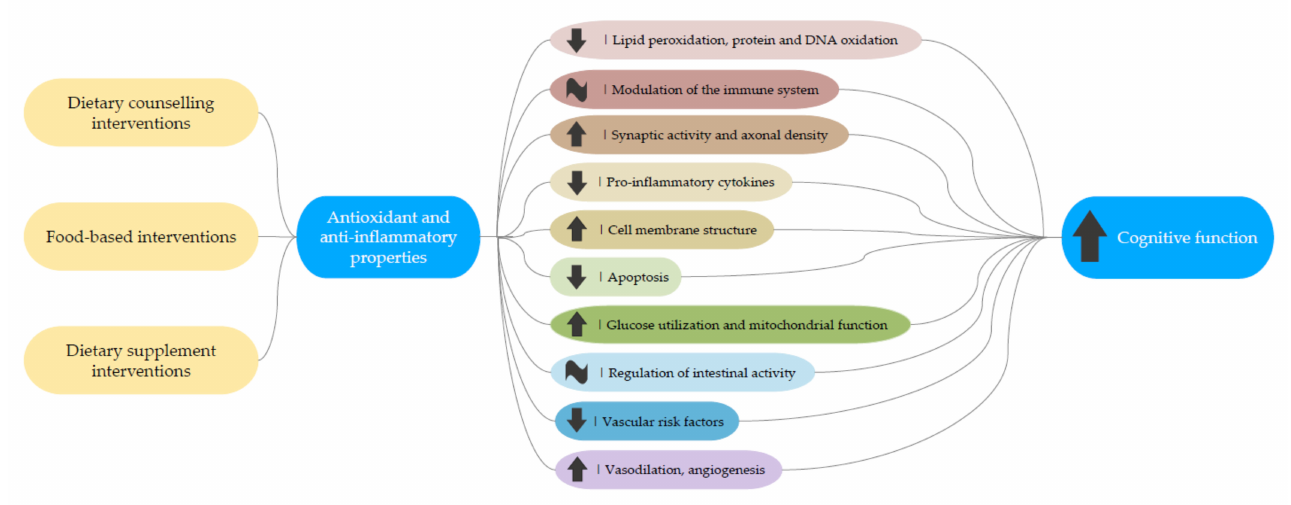
Figure 6. Potential mechanisms linking dietary interventions with cognitive function